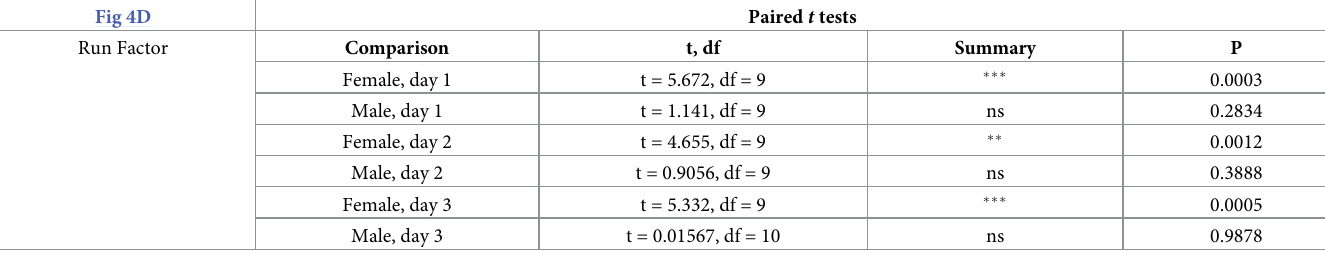
Table 5. Statistical analysis of data shown in Fig 4D for place learning, cohort A, Run comparison. Fig 4D Paired t tests Run Factor